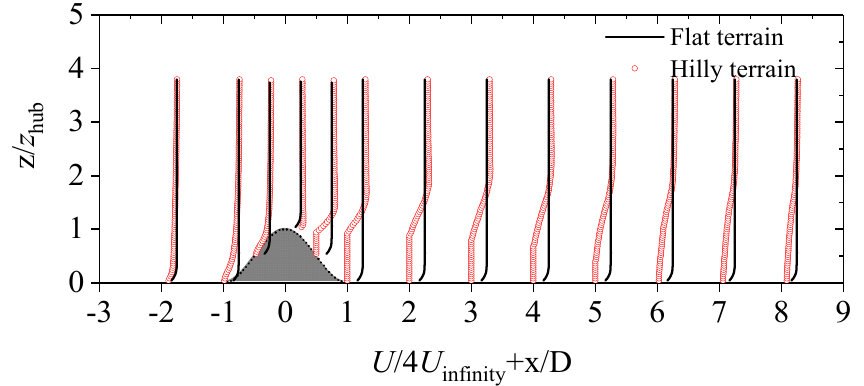
Figure 8. The mean velocity at various locations around a single two-dimensional cosine hill. Since the hot-wire anemometer cannot accurately acquire the negative wind speed. As a consequence, the first measuring point with an average velocity less than 0.4 m/s (i.e., U / U infinity < 0.05) from top to bottom in each vertical position was taken as the dividing point of positive and negative wind velocity in the data processing of this paper.